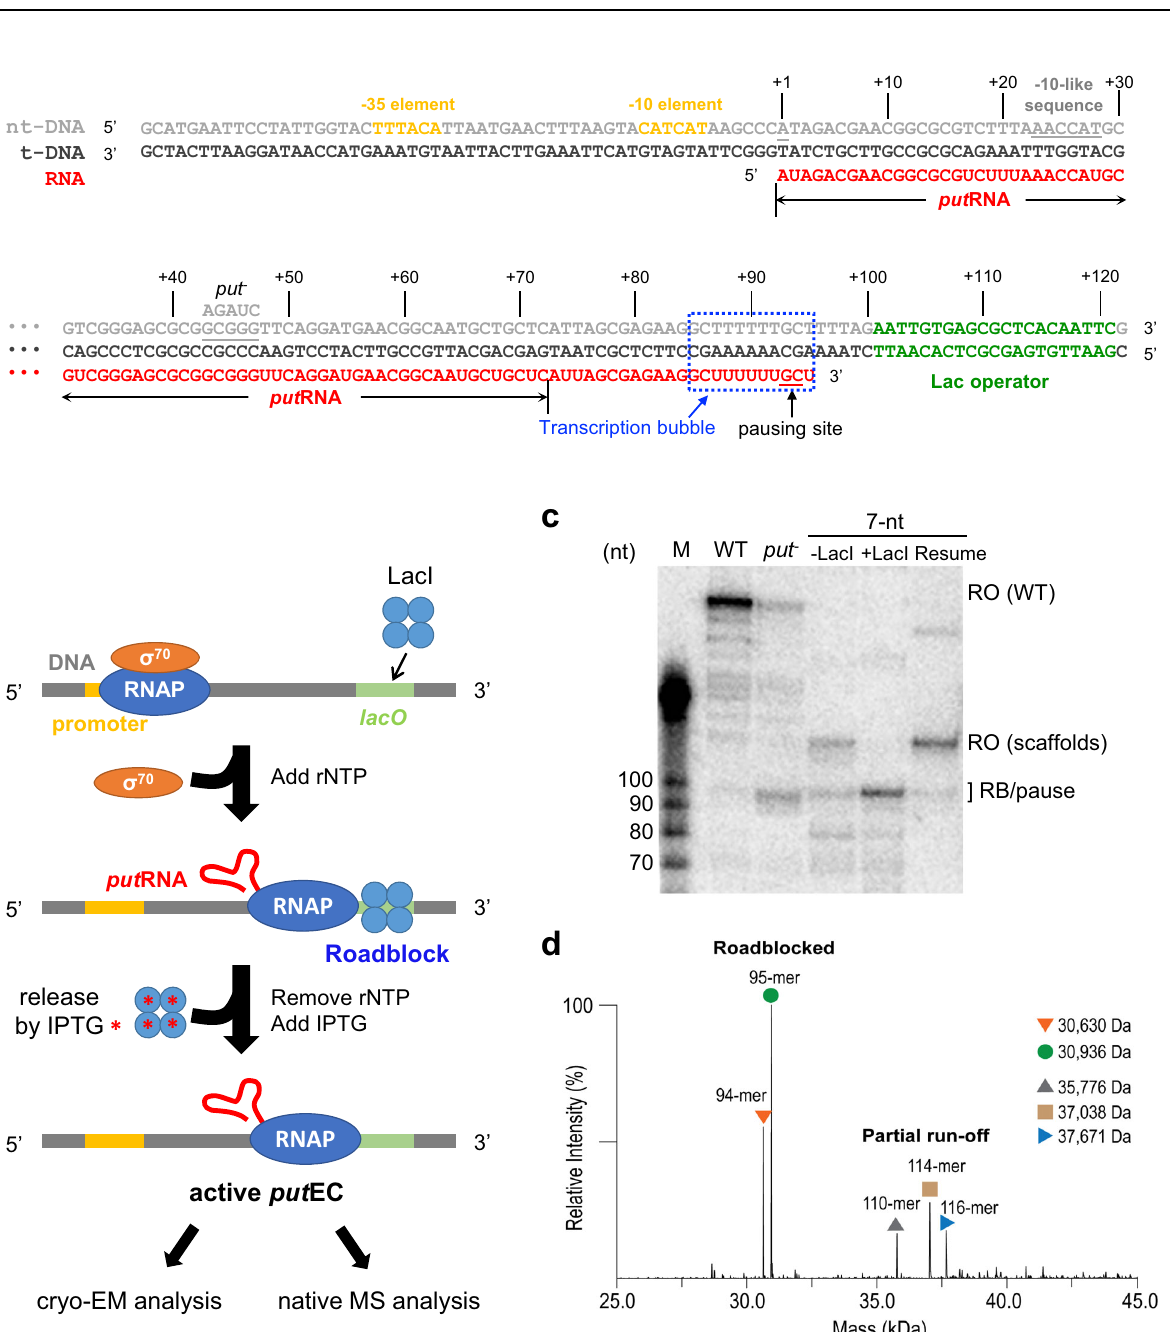
Fig. 1 | Scaffold design, reconstitution strategy, and evaluation for the put EC. a Thenucleicacidscaffoldinthereconstituted put EC.TheDNAwassynthesizedby PCR, and the RNA is synthesized in vitro from Eco RNAP holoenzyme by adding rNTP as described in b . The transcription regulation elements including − 35 ele- ment, − 10element, put RNA, − 10-likesequence,thepausingsite,and lacO sequence for roadblocking are shown. Transcription bubbleis marked with blue dotted box. Transcriptnumbering iswrittenfor reference. b A schematic diagramofthe put EC reconstitution. First, Eco holoenzyme containing Eco RNAP and σ 70 binds to the promoter region of the DNA forming RPo. LacI is added to the RPo to make a roadblock at the lacO site and rNTP is added to initiate the transcription. After transcribing put RNA,theRNAPstallsduetotheroadblockingLacI.Then,freerNTP is removed by using size-exclusion column before LacI is detached by IPTG to prevent furtherRNAsynthesis. The prepared,active put ECisused for